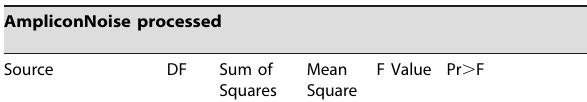
Figure 3. Impacts of de-noising on OTU richness and diversity. A) Relationship between OTU richness with and without de-noising, by sample. B) Relationship between OTU diversity (Shannon index) with and without de-noising, by sample. C) Ranking of samples by Shannon diversity index with and without de-noising.